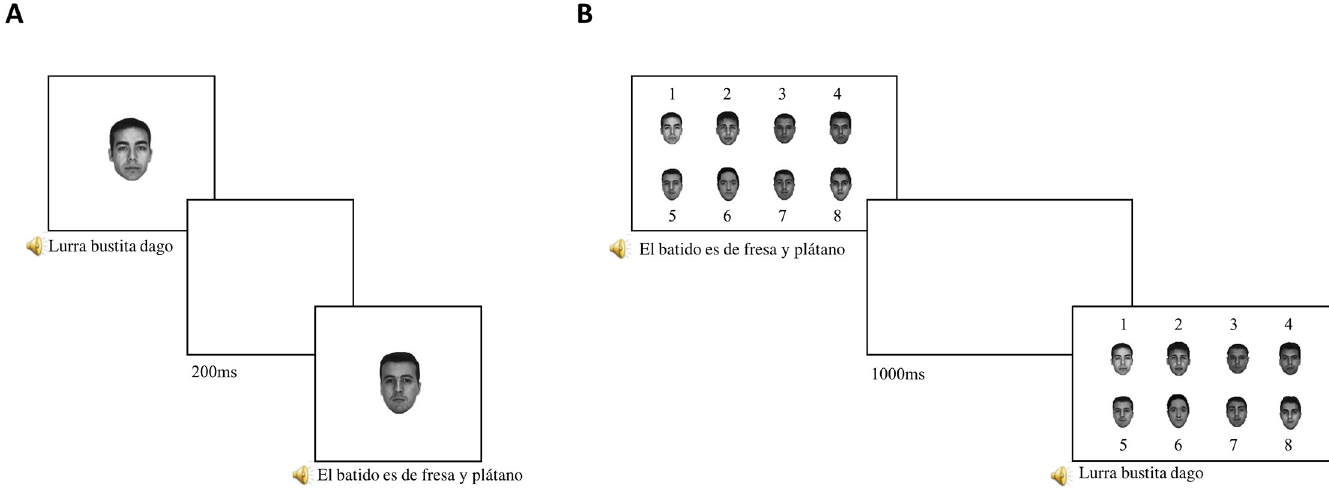
Fig 1. The procedure of the Memory Confusion Paradigm (MCP). This diagram shows the two phases of the MCP. On Panel A, the encoding phase, where faces were presented with the audio sentences. On panel B, the final recognition phase. Grayscale photos of eight Caucasian males with neutral expressions were selected from the free AR face database